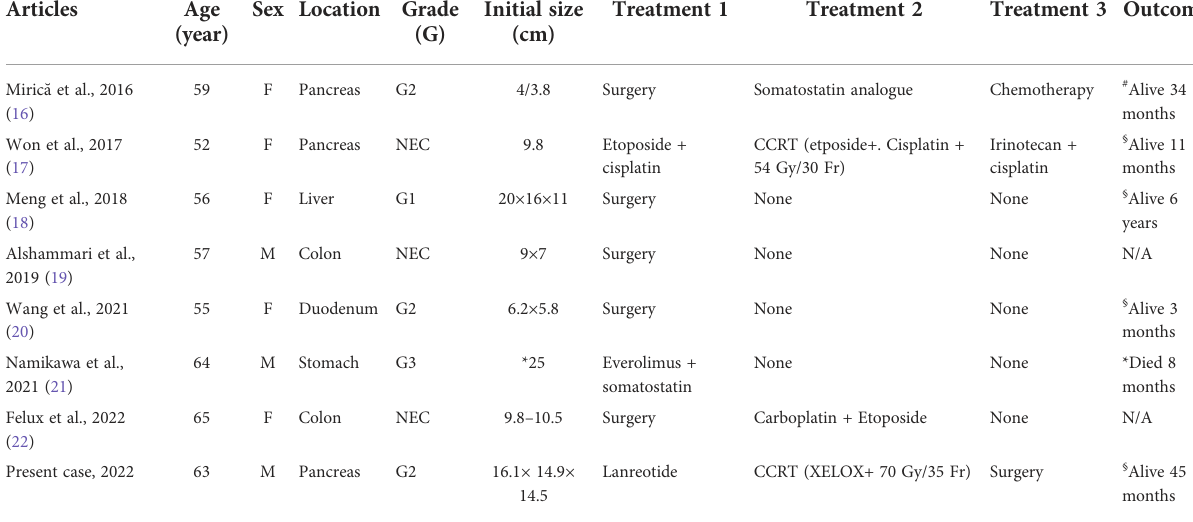
TABLE 1 Clinicopathological characteristics of reported cases of locally advanced abdominal neuroendocrine tumor.